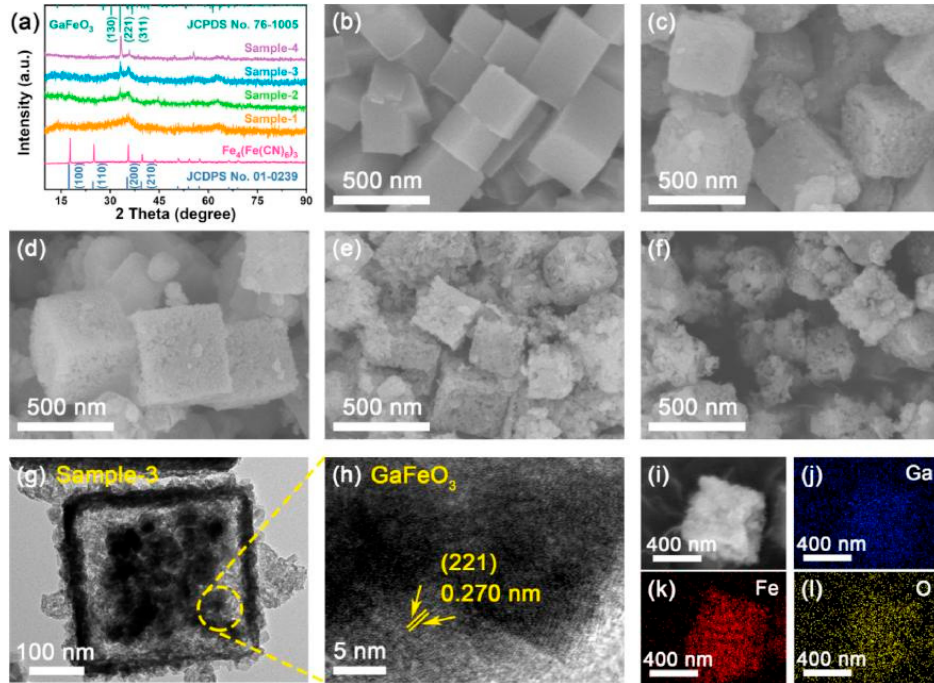
Figure 4. ( a ) From bottom to top, the simulated and experimental XRD patterns of Fe 4 [Fe(CN) 6 ] 3 MOFs (JCPDS No. 01–0239), the experimental XRD patterns of Samples-1, -2, -3, -4, and the simulated XRD pattern of GaFeO 3 phase (JCPDS No. 76–1005). The FE-SEM images of ( b ) Fe 4 [Fe(CN) 6 ] 3 MOF precursors and ( c – f ) porous GaFeO 3 microcubes of Samples-1, -2, -3 and -4 obtained at 400, 450, 500, and 550 °C, respectively. ( g ) TEM and ( h ) HRTEM images of Sample-3 obtained at 500 °C. ( i ) The selected SEM image of Sample-3 and the corresponding elemental mapping images of ( j ) Ga,